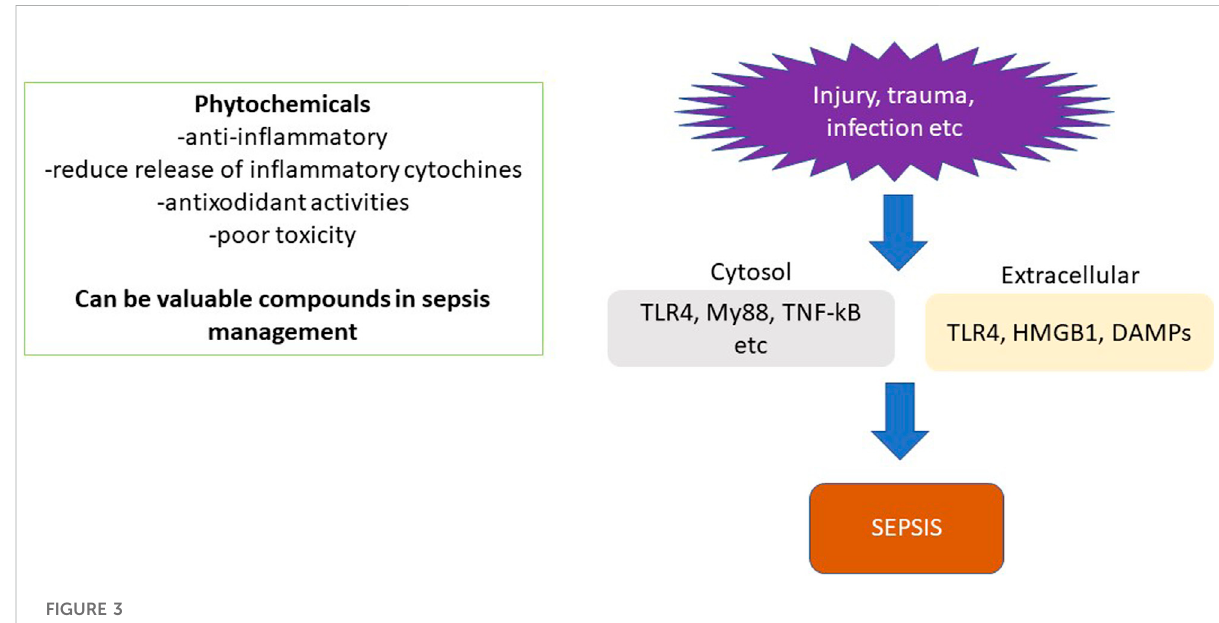
Molecular mechanism involved in sepsis.